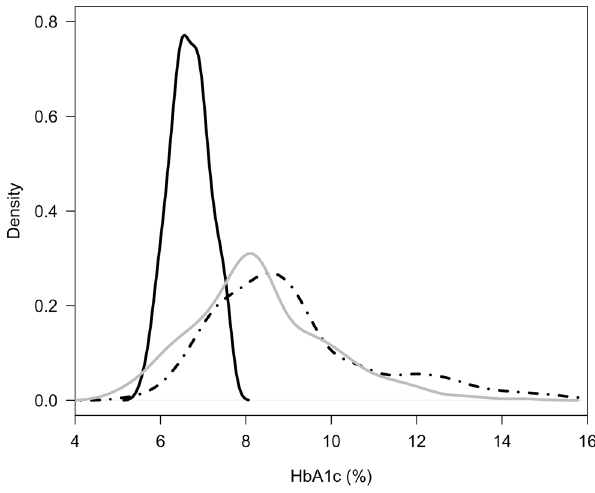
Figure 5. Density plots to show the distribution of HbA1c results for GCK, type 1 and type 2 diabetes. GCK = solid black line, type 1= dashed line and type 2= grey solid line. To convert values for HbA1c in% into mmol/mol, subtract 2.15 and multiply by